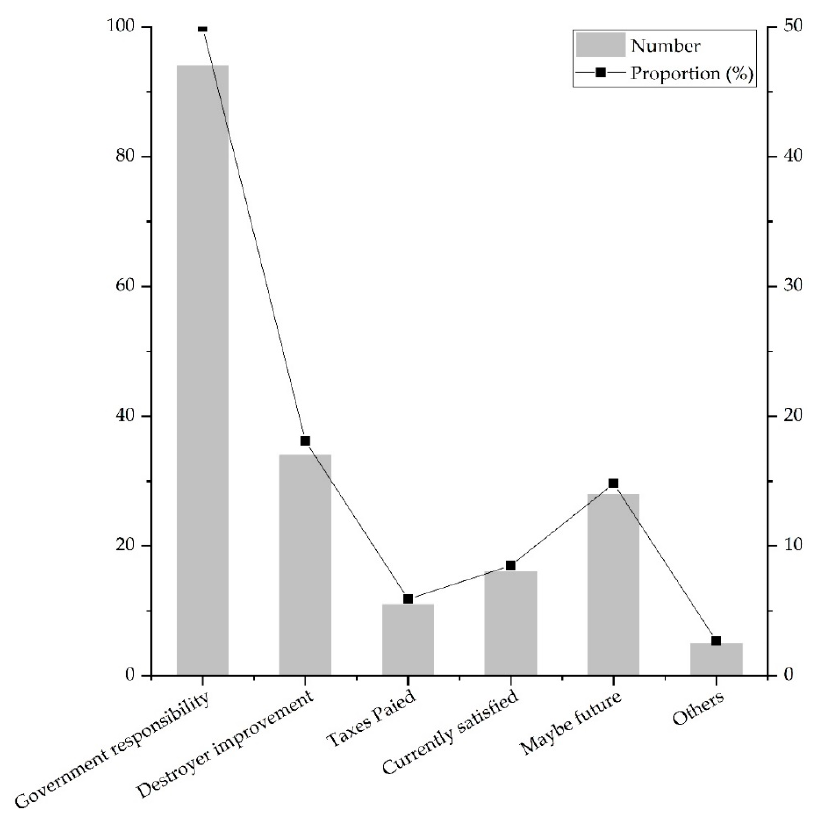
Figure 5. The quantity and proportion of different reasons for refusal to pay.